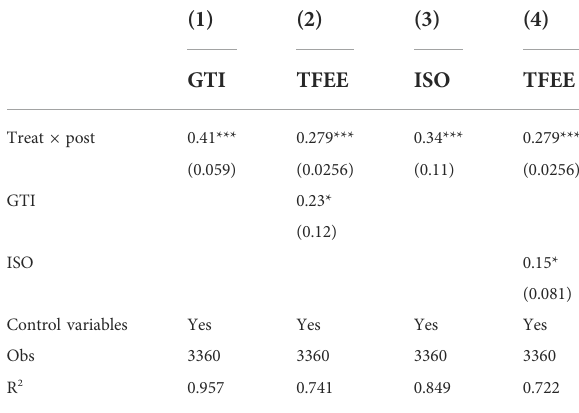
TABLE 6 Mediating effects of GTI and ISO. TABLE 7 Heterogeneity effect of GFPP on